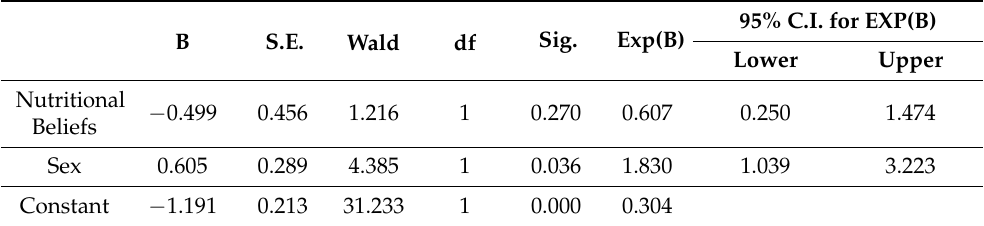
Table 4. Binomial logistic regression between orthorexia nervosa, unhealthy self-rules, and sex of students from a Brazilian Public